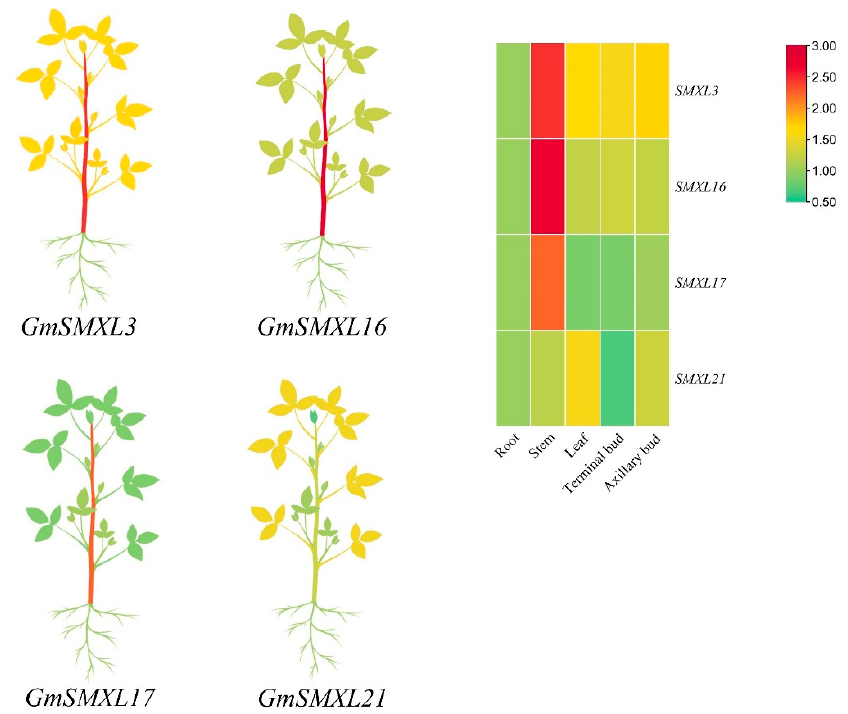
Figure 8. The differential expression of representative GmSMXL genes in five tissues by RT-qPCR. The mean expression value was visualized by Tbtools; red represents high expression level and green represents low expression level.